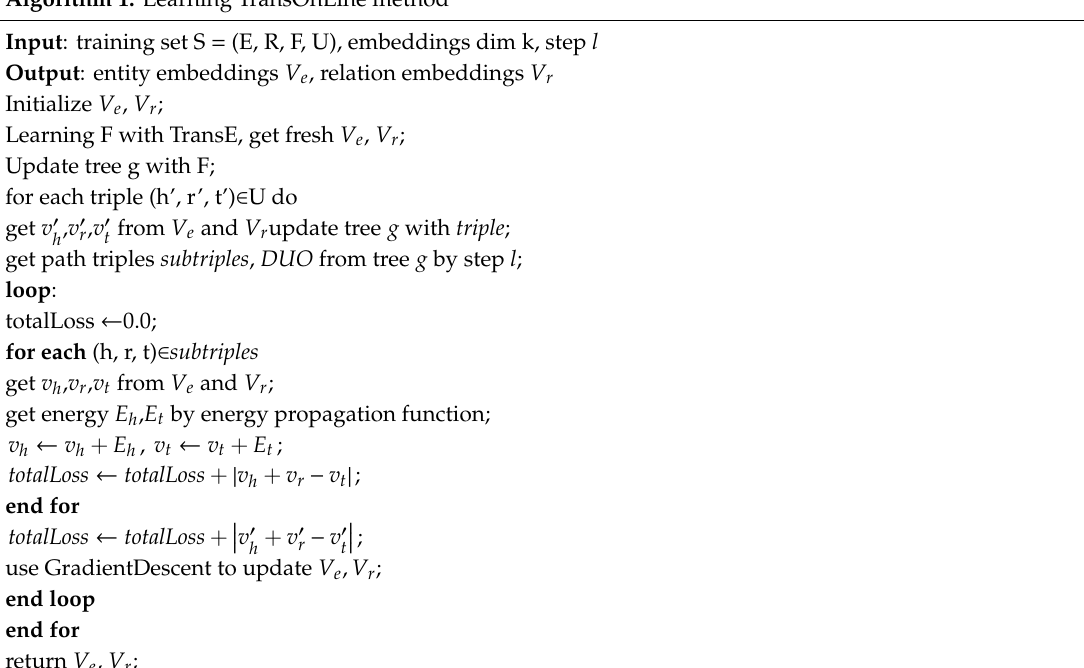
Algorithm 1. Learning TransOnLine